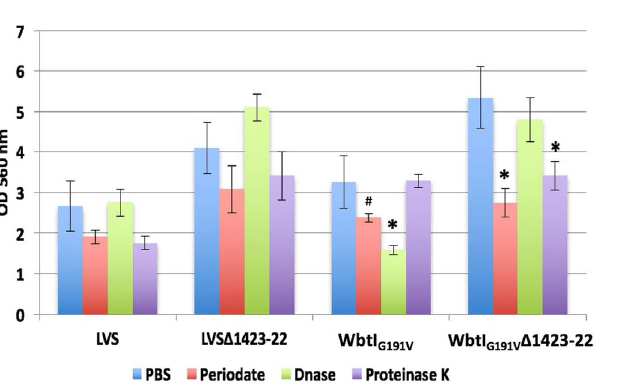
Table 3. Francisella tularensis Type A strain SchuS4 genes with amino acid identity to glycogen synthesis proteins in heterologous bacteria. a Type A SCHUS4 locus tag, followed by the Type B LVS locus tag listed underneath. b Genus other than Francisella with the closest amino acid identity.